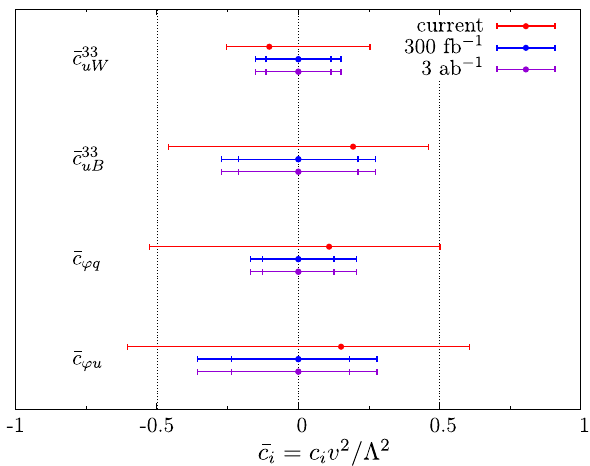
Fig. 2 Individual 95% confidence intervals on the coefficients of the operators of Eq. (II.4) using the current 13 TeV measurements ( red bars ). Also shown are the projected constraints using 300 fb − 1 ( blue ) and3ab − 1 ( purple )ofSMpseudodata.Forthelattertwocases,the inner bars show the improvement when theory uncertainties are reduced to